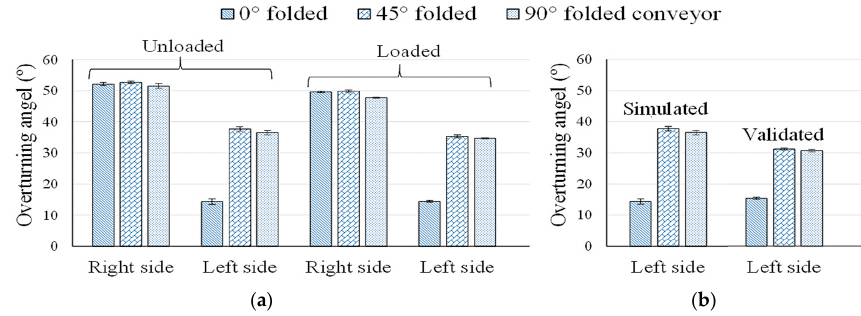
Figure 6. Lateral overturning angles of the tractor–collector system: ( a ) simulated overturning angles under unloaded and loaded conditions, and ( b ) angle difference between simulation and validation.